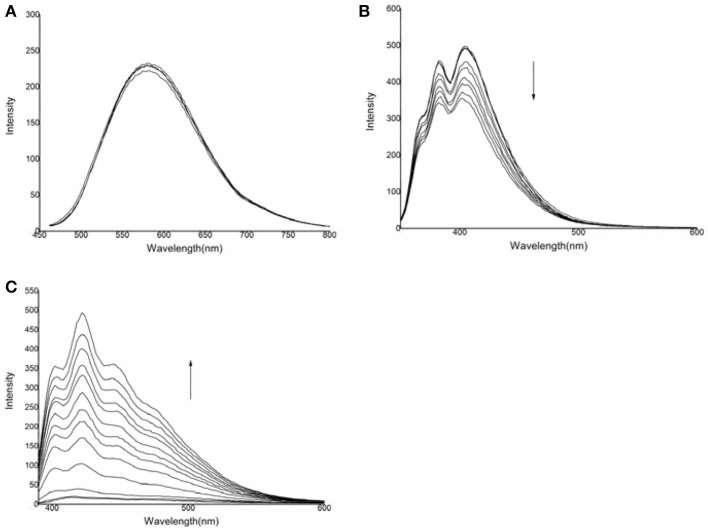
Changes in the emission spectra of the three compounds in the presence of HS−: (A) compound 1: 6.9 × 10−5 mol·L−1, HS−: 0–20.7 × 10−5 mol·L−1, λex = 442 nm; (B) compound 2: 1.46 × 10−4 mol·L−1, HS−: 0–50.1 × 10−4 mol·L−1, λex = 324 nm; (C) compound 3: 1.1 × 10−4 mol·L−1, HS−: 0–7.7 × 10−4 mol·L−1, λex = 368 nm.